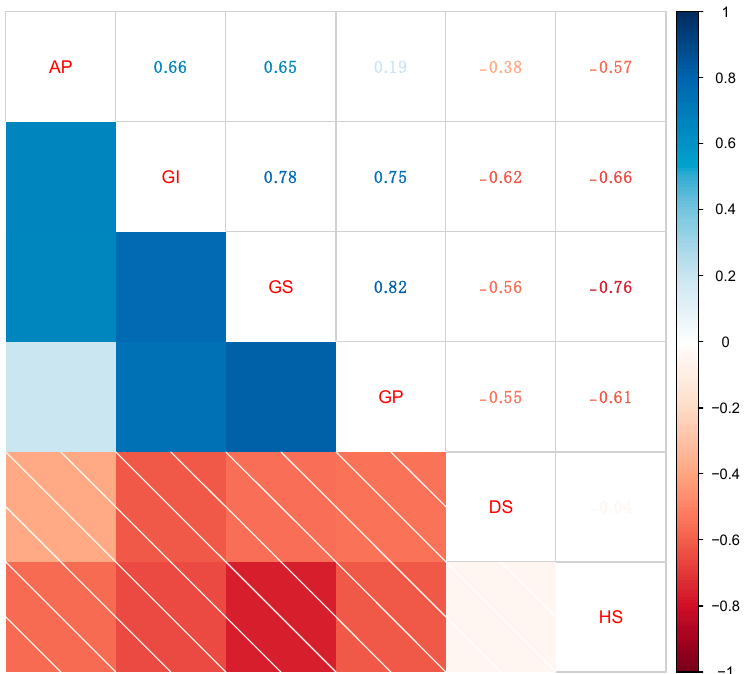
Figure 2. Correlation of physiological variables of piquin pepper, (GS) Germination speed, (GI) Germination index, (GP) Germination percentage, (AP) Abnormal seedlings, (DS) Dead seeds, (HS) Hard seeds.